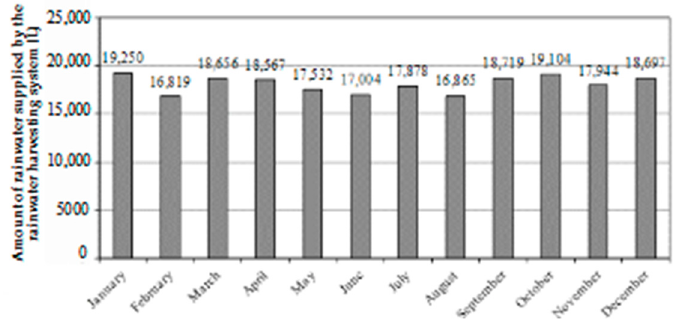
Figure 11. Monthly rainwater supplied by the rainwater harvesting system.